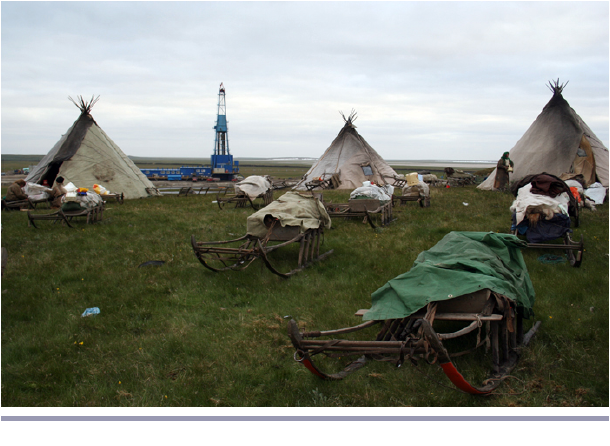
Fig. 8 . Nenets camp next to a new drill rig in BGF, July 2011. Photo by B.C. Forbes.